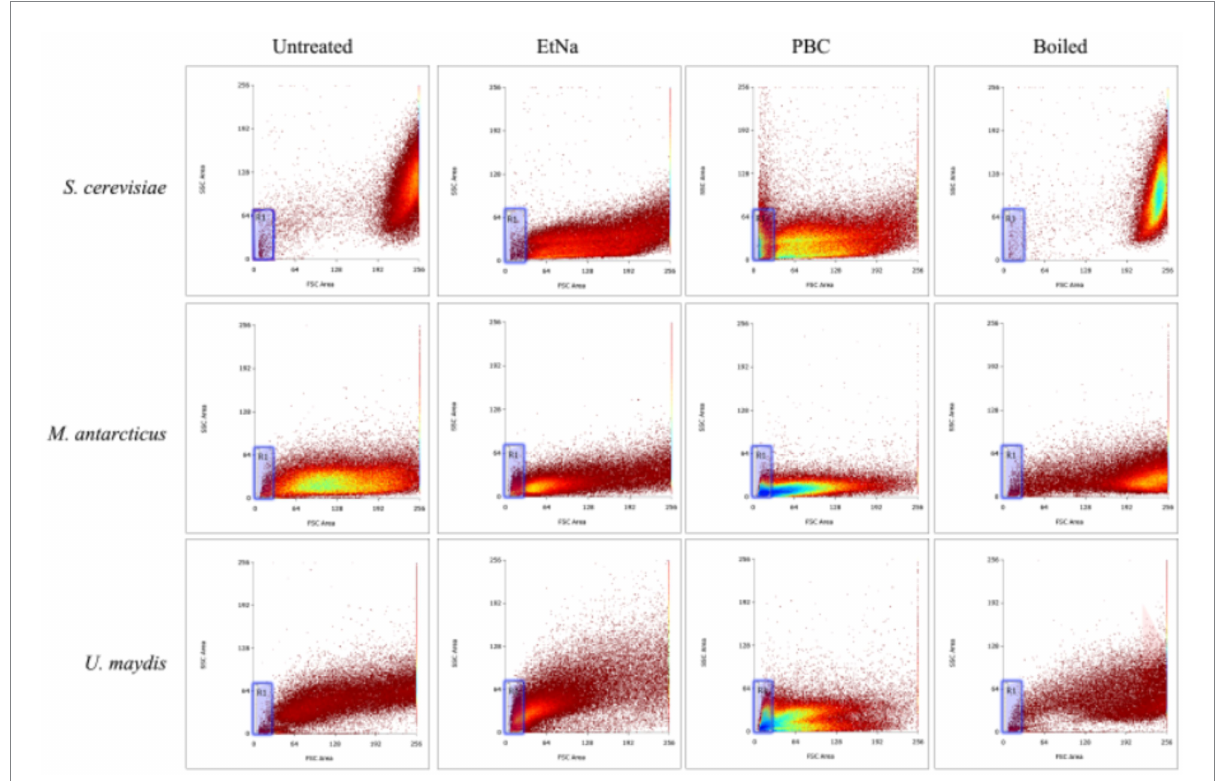
FIGURE 4 Flow cytometry analysis of microbial cells with different treatments. Flow cytometry was used to detect the cell states of S. cerevisiae , M. antarcticus and U. maydis after 100 ° C water bath (boiled), PBC and EtNa treatments, respectively. Untreated cells were used as control. The “R1” area is marked with a blue frame.